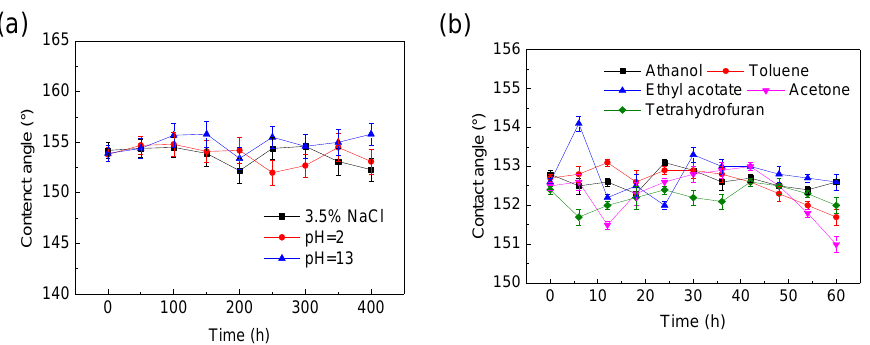
Figure 8. Relation between contact angle of filter mesh surface and soaking time after soaking in different chemical media: ( a ) acid–alkali–salt resistance; ( b ) organic solvent resistance.